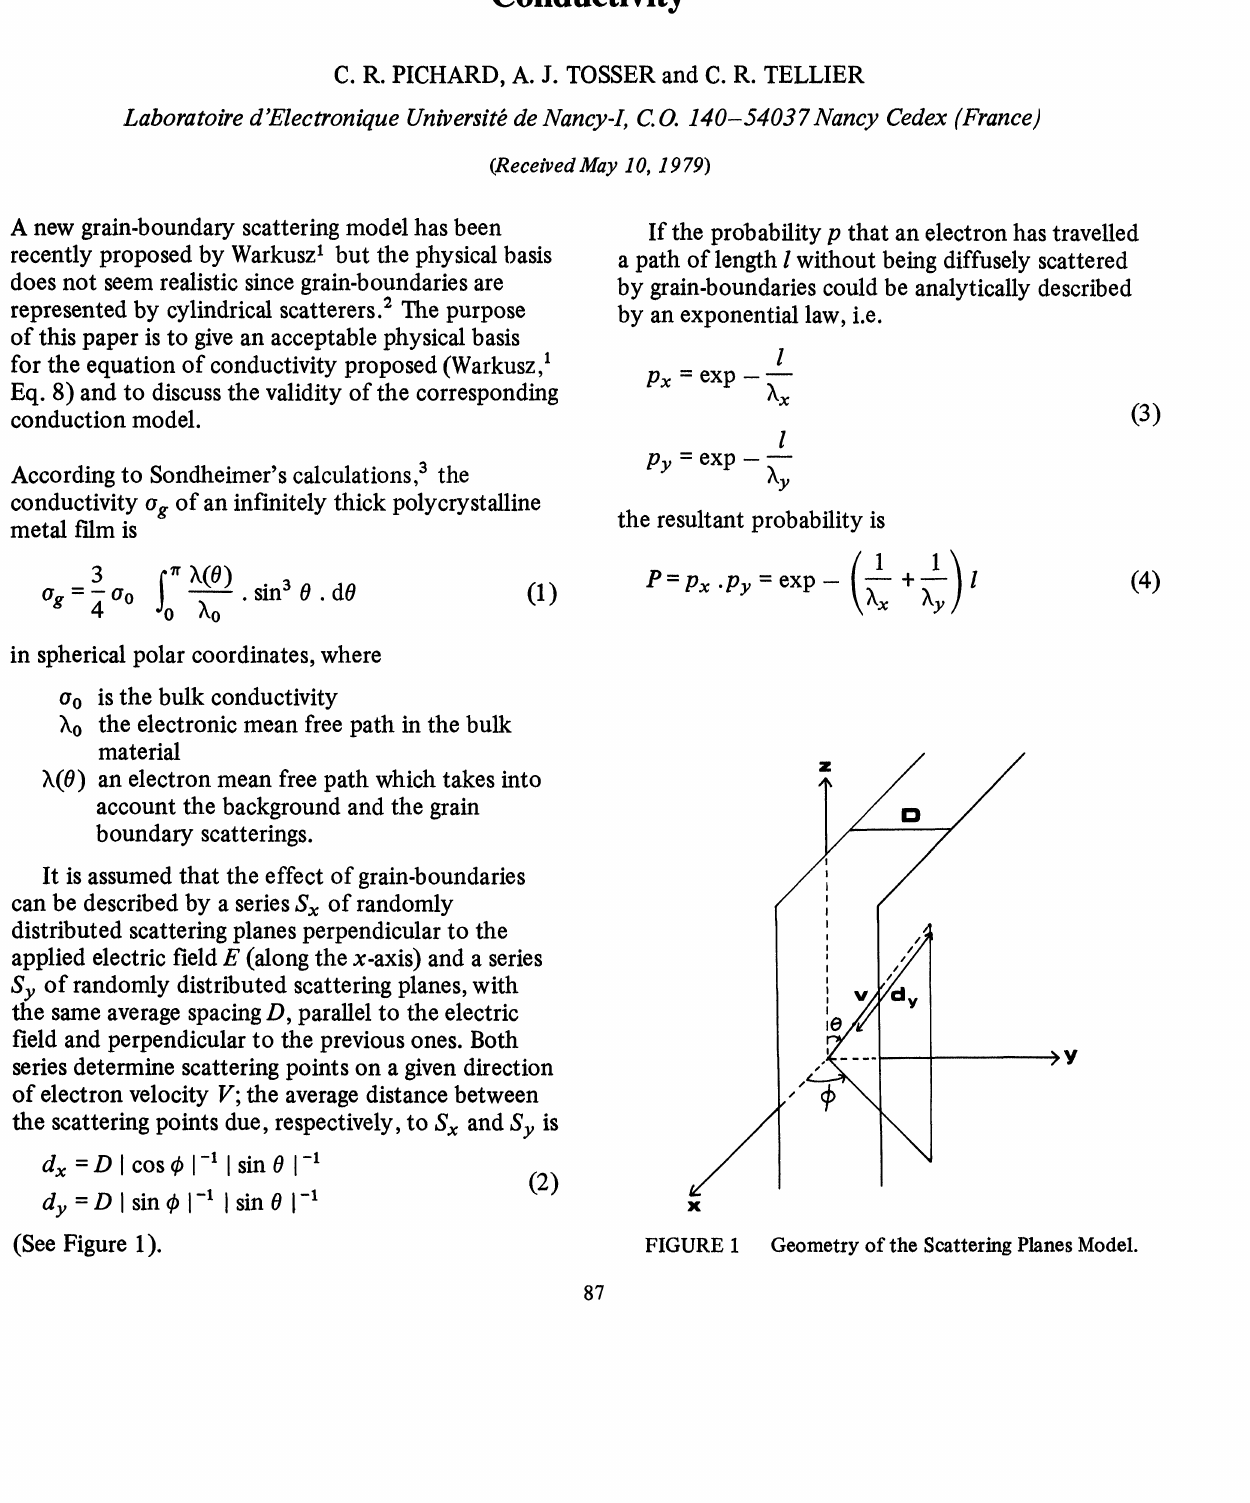
Geometry of the Scattering Planes Model.